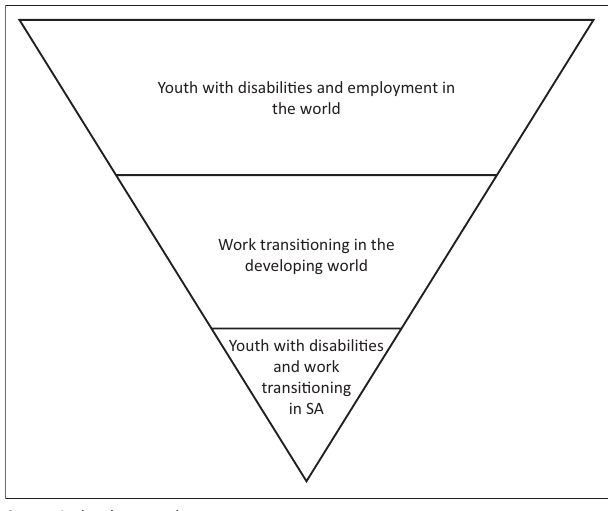
FIGURE 1: Themes used to extract information from